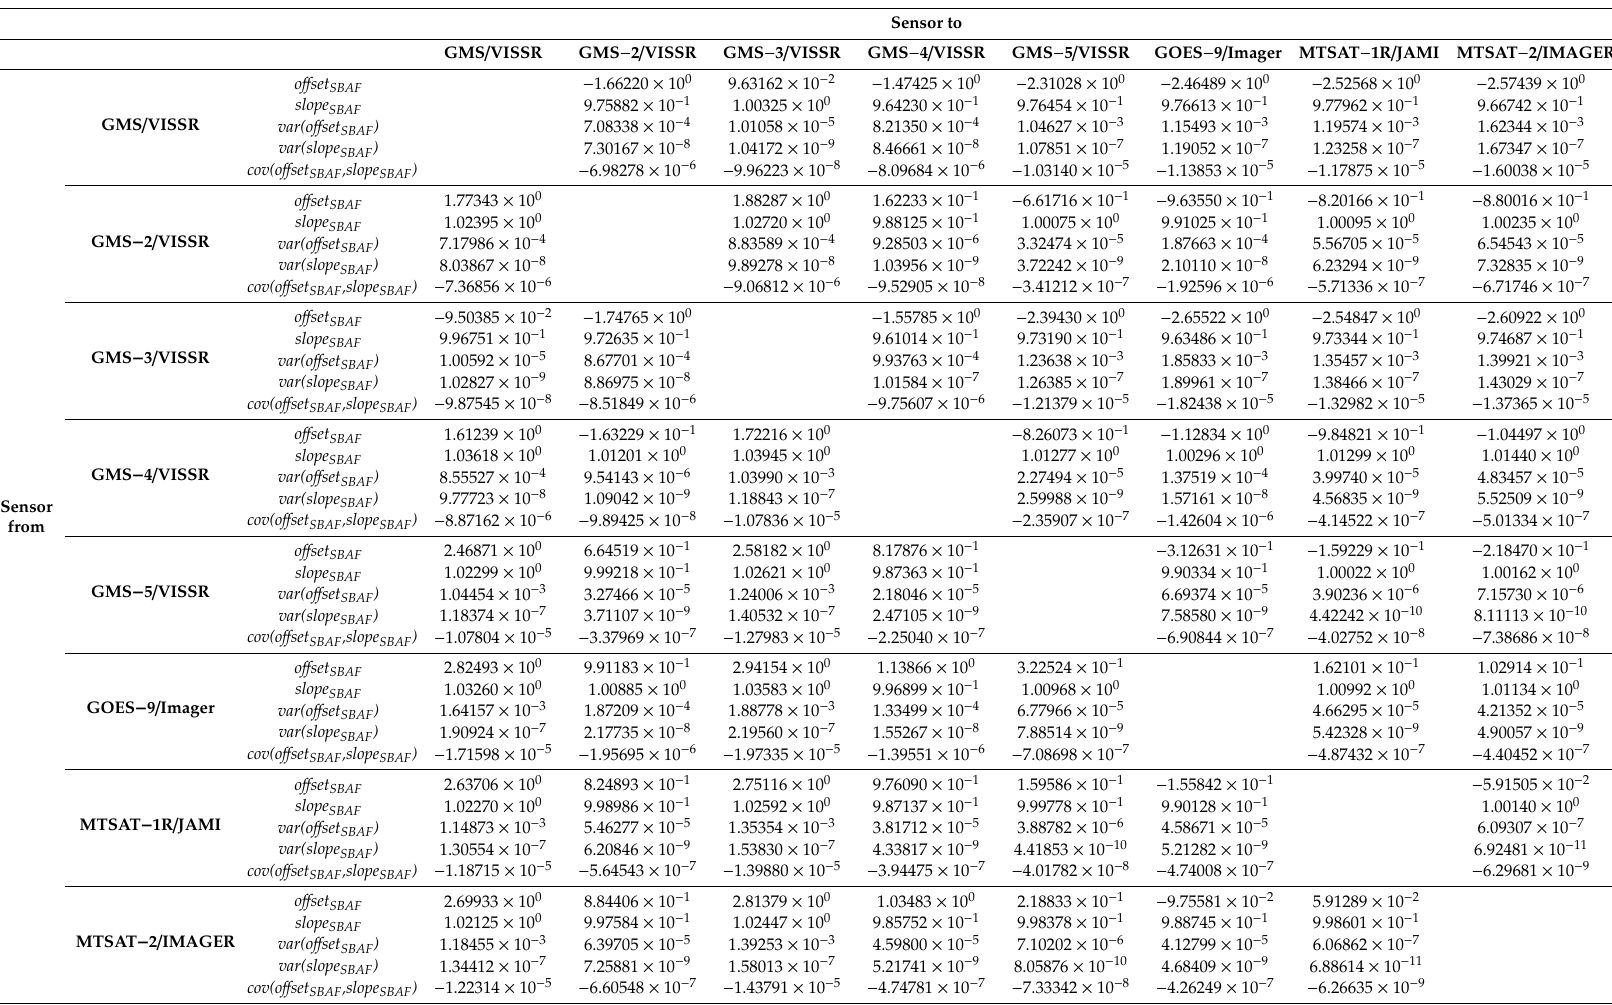
Table A3. SBAFs for converting IR channel radiances between di ff erent historical JMA satellites (unit: mW / (m 2 sr cm − 1